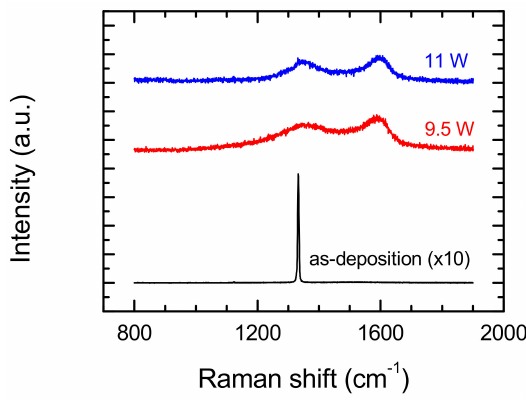
Figure 8. E ff ect of laser power on Raman spectra from modified surface of polycrystalline diamond. Scan speed during the laser etching process: 400 mm / s, hatching distance—10 µ m.